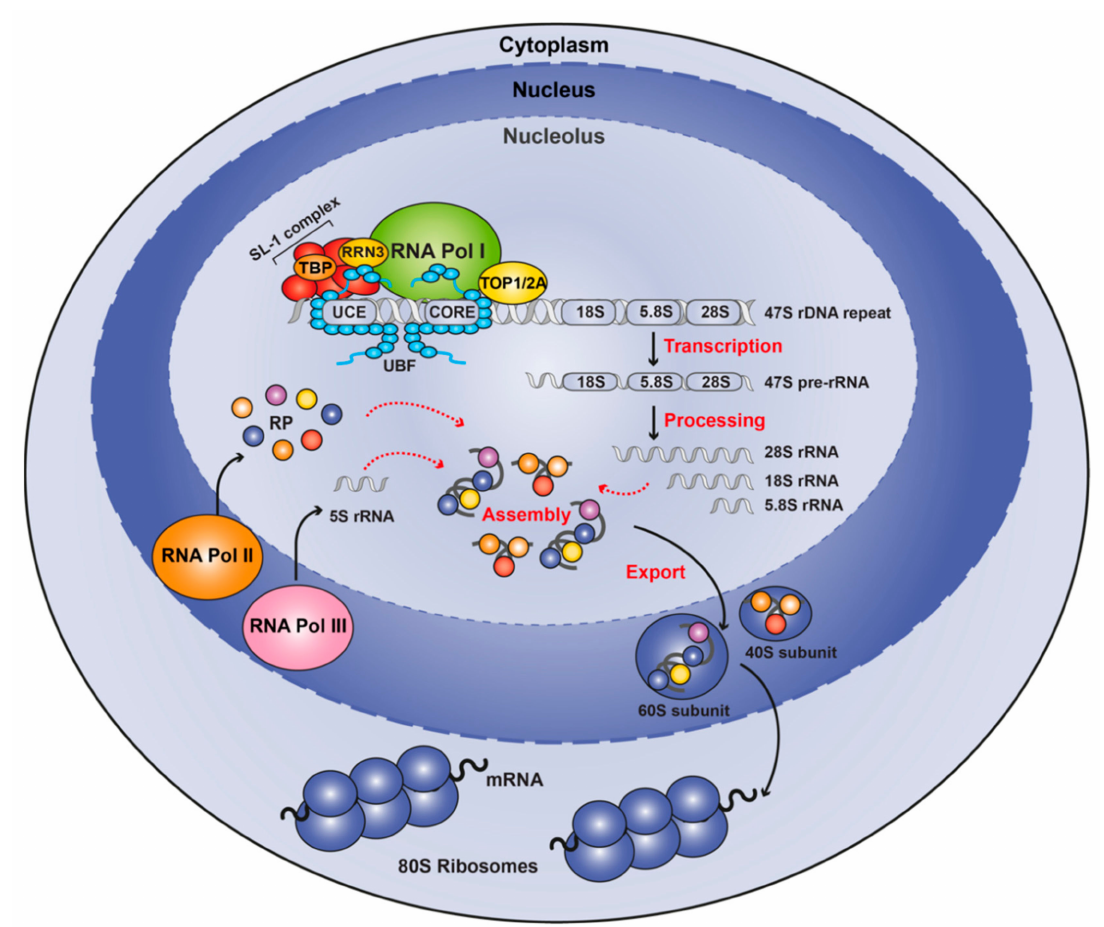
Figure 1. Schematic overview of ribosome biogenesis. Ribosome biogenesis occurs in nucleoli, which form around actively transcribing repeats of 47S ribosomal DNA. For Pol I transcription to initiate, UBF binds to the regulatory regions and recruits the SL-1 complex that interacts with Pol I via RRN3. Following synthesis, the 47S pre-rRNA is processed and modified to generate the mature 18S, 5.8S, and 28S rRNAs, which together with the 5S rRNA transcribed by Pol III, and ribosomal proteins transcribed by Pol II are assembled to form the 40S and 60S ribosomal subunits. These are subsequently exported from the nucleolus to the cytoplasm, where they form the mature 80S